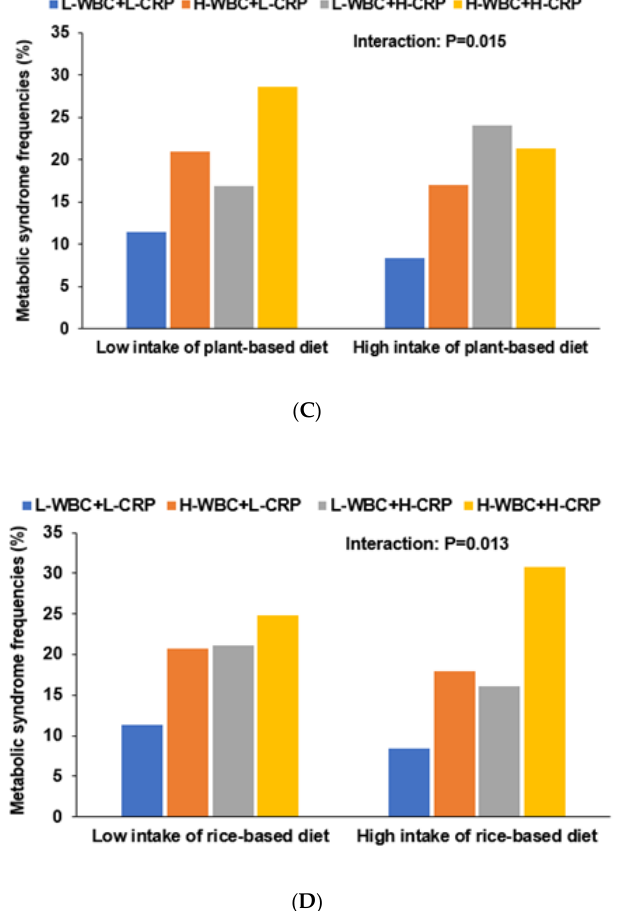
Figure 2. The frequency distribution of metabolic syndrome in four different groups categorized by white blood cell counts and serum CRP. ( A ) The incidence of metabolic syndrome of 4 groups according to smoking status. ( B ) The incidence of metabolic syndrome of 4 groups according to the intake of a Korean balanced diet pattern (cutoff point: 70th percentile). ( C ) The incidence of metabolic syndrome of 4 groups according to the intake of a plant-based diet pattern (cutoff point: 70th percentile). ( D ) The incidence of metabolic syndrome of 4 groups according to the intake of a rice-based diet pattern (cutoff point: 70th percentile).